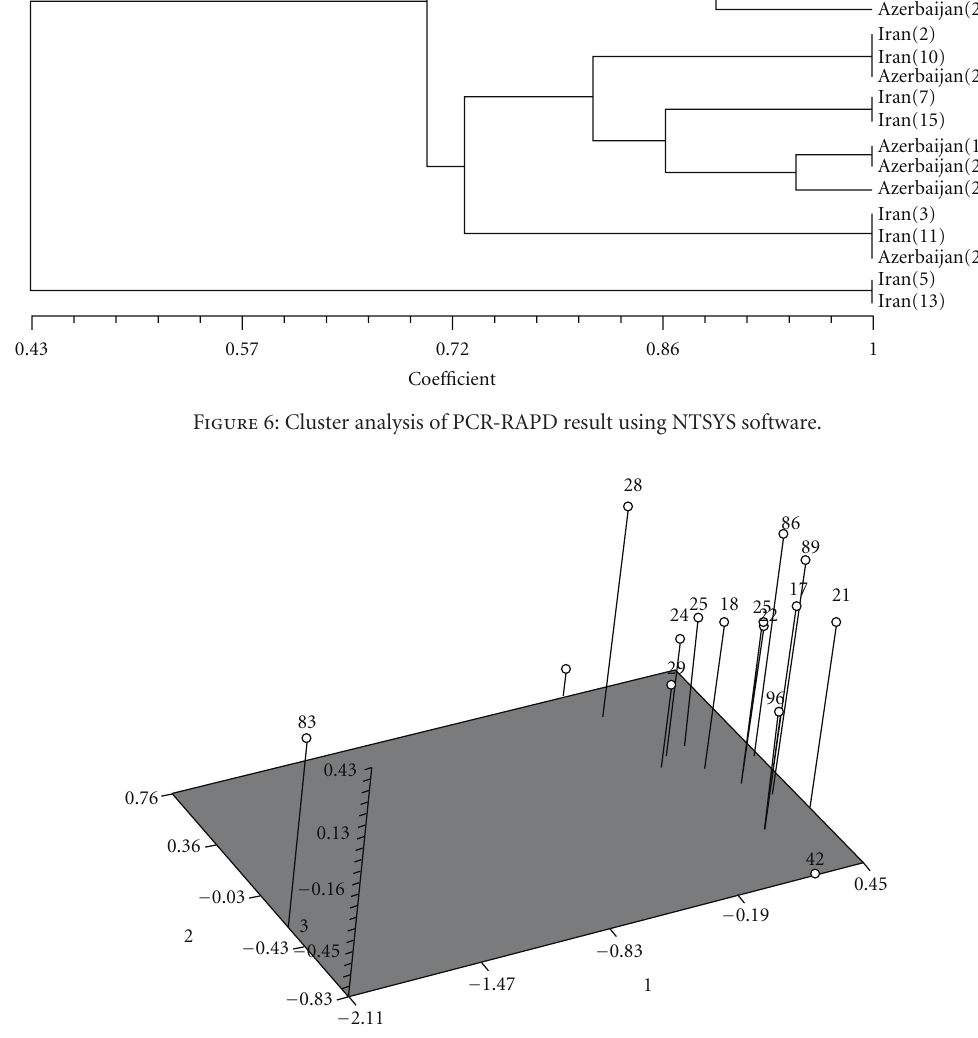
Figure 7: PCA analysis for classification of birds using NTSYS